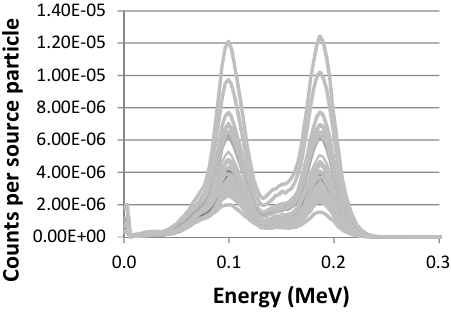
Fig.9. Simulation of the impact of the source’s location on spectra (31 spectra).